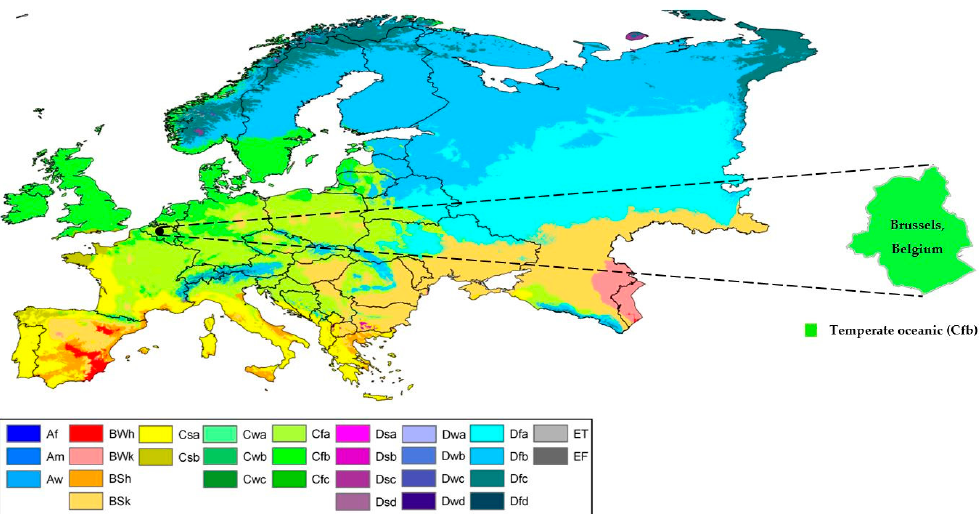
Figure 2. Reference building location and climate zone as per the Köppen–Geiger classification [18].